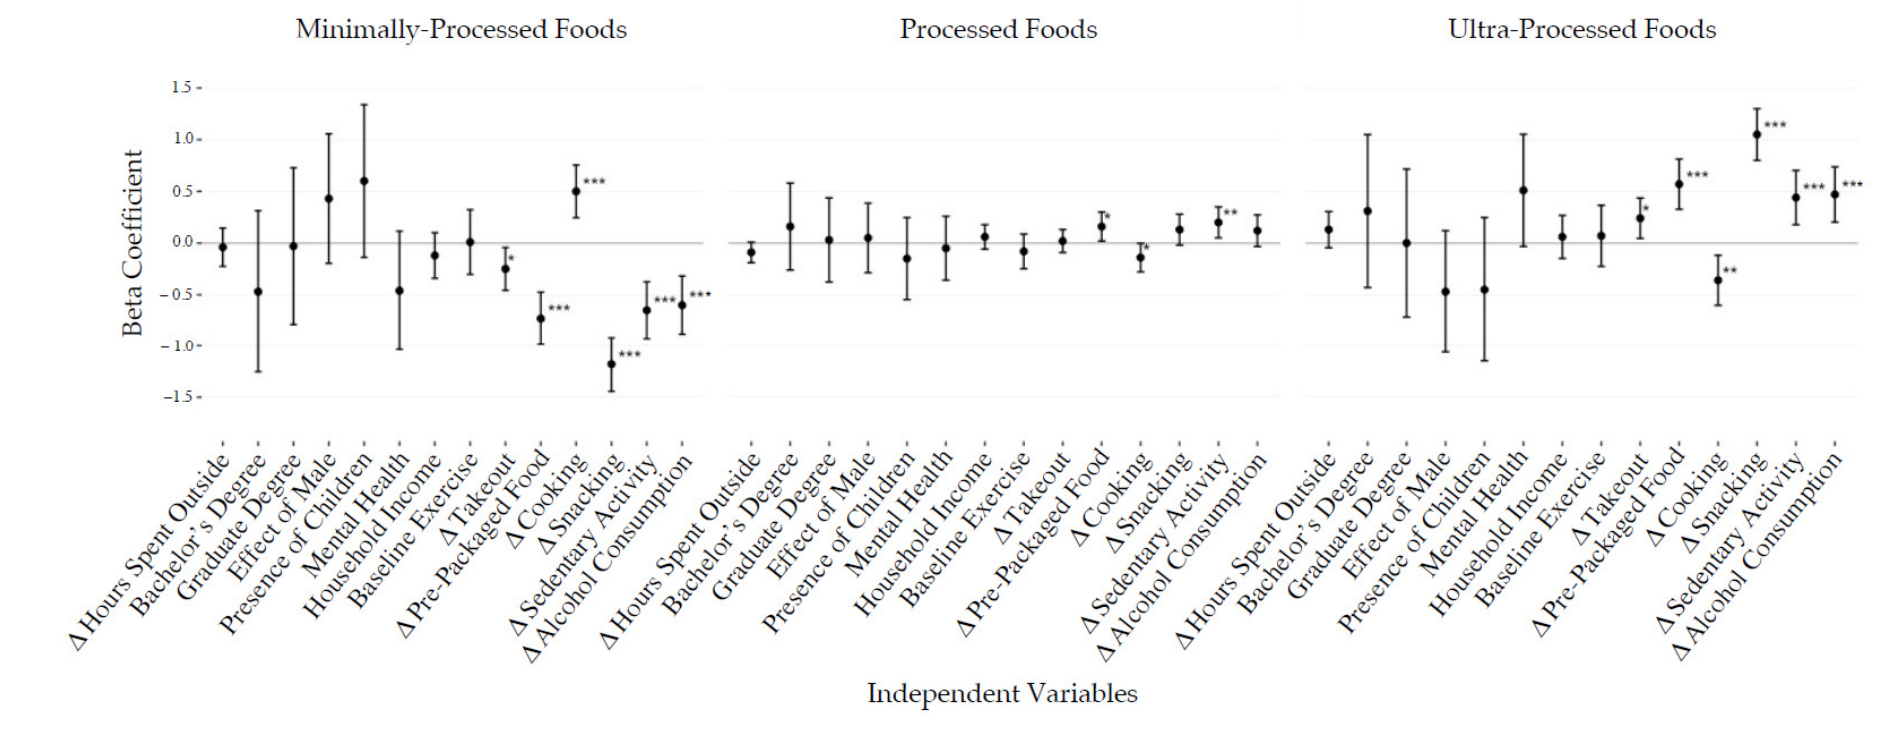
Figure 1. Univariate linear regression outputs presenting the relationships between behavioral, demographic, and anthropometric factors to change in percent calories from minimally processed (MPF), processed (PF), and ultra-processed foods (UPF). Results are presented as beta coefficients with 95% confidence intervals. * p < 0.05, ** p < 0.01, *** p < 0.001.